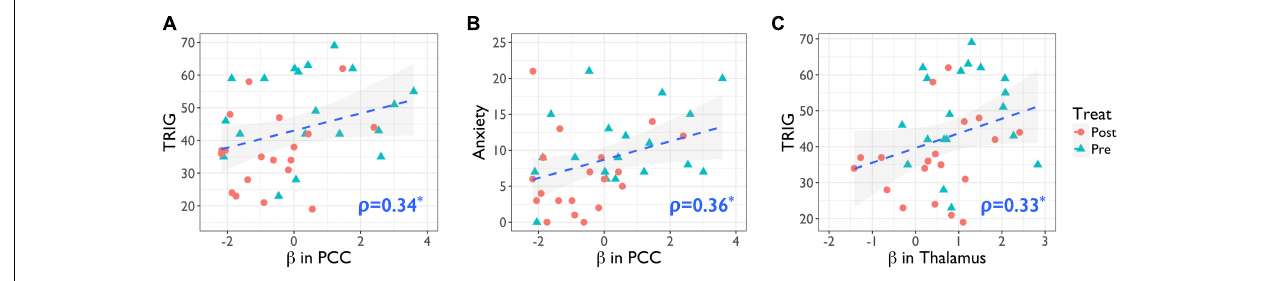
FIGURE 2 | Positive associations of neuropsychological tests and the brain activity (beta value) in the incongruent condition of numerical Stroop task. (A) PCC activity in numerical Stroop associated with the TRIG score, r = 0.34, p < 0.04; (B) PCC activity in numerical Stroop associated with the Anxiety score, r = 0.36, p < 0.03; (C) thalamus activity in numerical Stroop associated with the TRIG score, r = 0.33, p < 0.05. Statistical significance was based on Spearman’s ρ . PCC, posterior cingulate cortex; TRIG, Texas Revised Inventory of Grief; Anxiety, Becker Anxiety